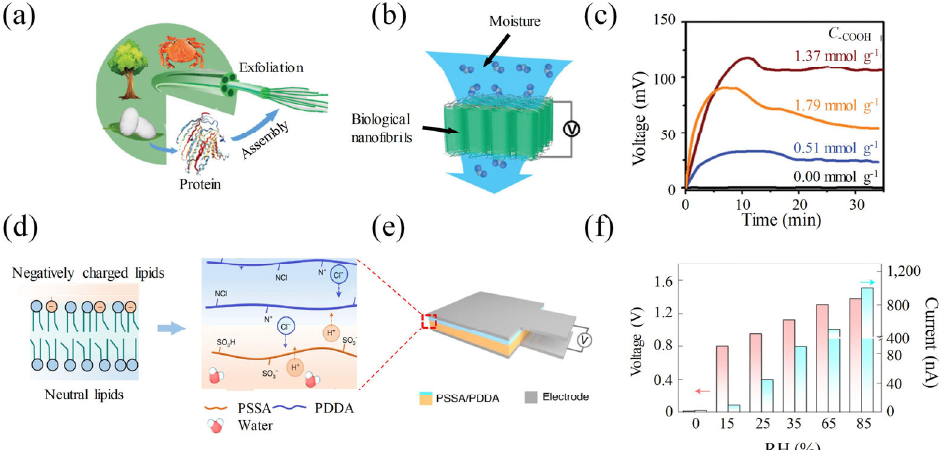
Figure 6 Bio-inspired moisture-driven electricity generator. (a) Schematic illustration of natural nanofibers. (b) Schematic illustration of biological generator under moist air flow. (c) Effect of carboxyl content on V oc . (a)–(c) Reproduced with permission from Ref. [123], © Wiley-VCH Verlag 2019. (d) Asymmetrical lipid bilayer inspired material for moisture-driven electricity generator. (e) Schematic illustration of bio-inspired structure of the HMEG. (f) Voltage and current in response to variation in RH. (d)–(f) Reproduced with permission from Ref. [124], © Wang, H. Y., et al.